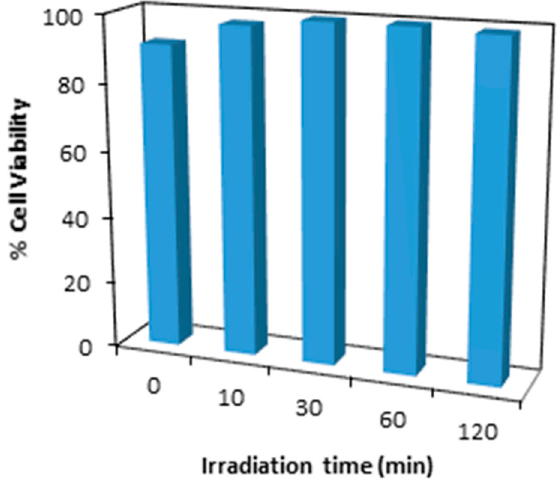
Figure 10. HEK-293 cell viability (%) in the aqueous medium during SMZ photodegradation under solar radiation in the presence of 5%rGO/Bi. [SMZ] 0 = 15 mg/L.